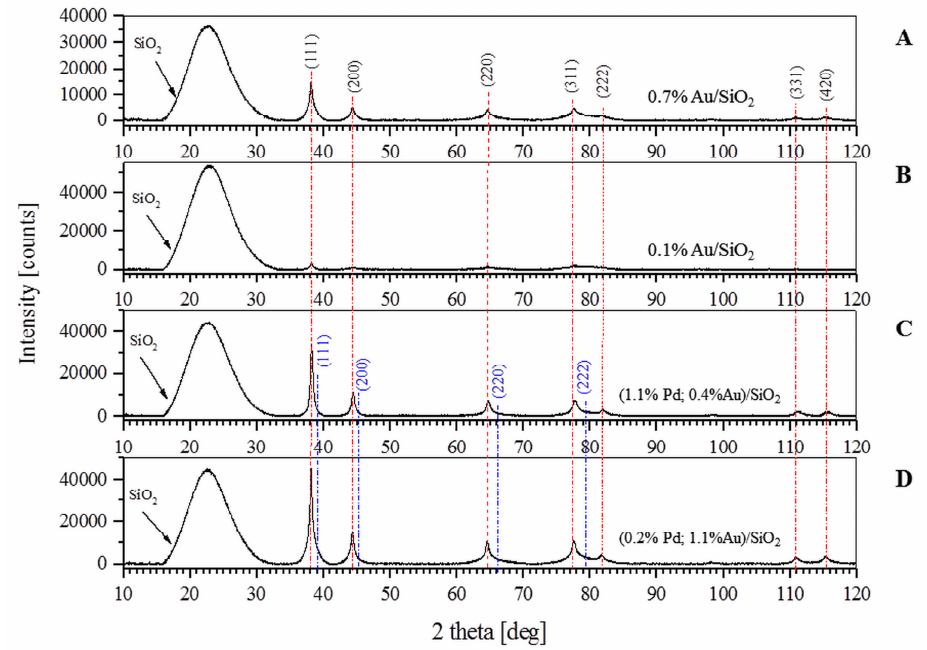
Figure 2. The X-ray diffraction patterns at 2 θ : 10°–120° for 0.7% Au/SiO 2 ( A ), 0.1% Au/SiO 2 ( B ), (1.1% Au; 0.4% Pd)/SiO 2 , and (0.2% Pd; 1.1% Au)/SiO 2 ( C , D ) samples. Miller indices for experimental peaks of Au (black) and Pd (blue) nanoparticles are marked.